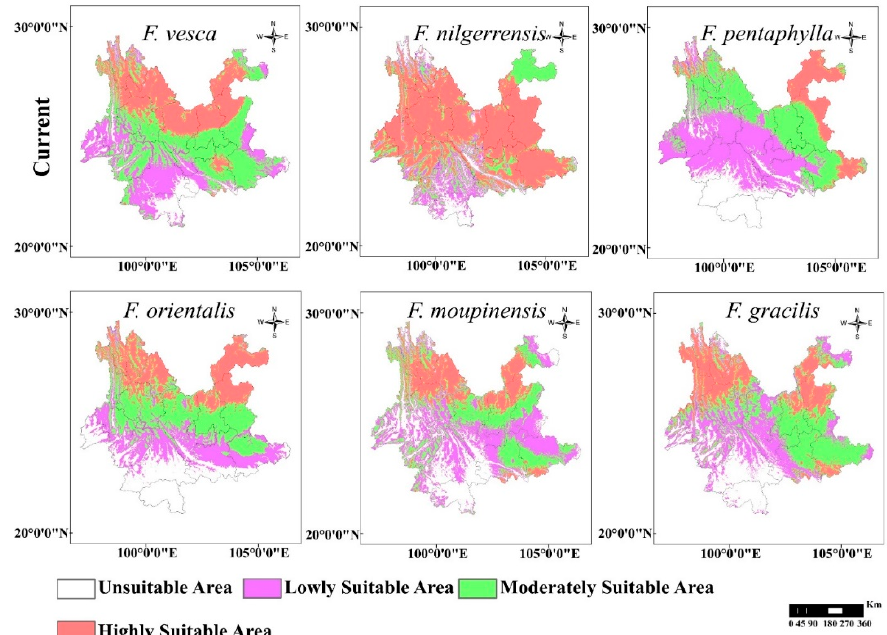
Figure 4. Potentially suitable areas for six wild strawberry species under the current climate scenario. “Current” represents current scenario (1970 to 2000).